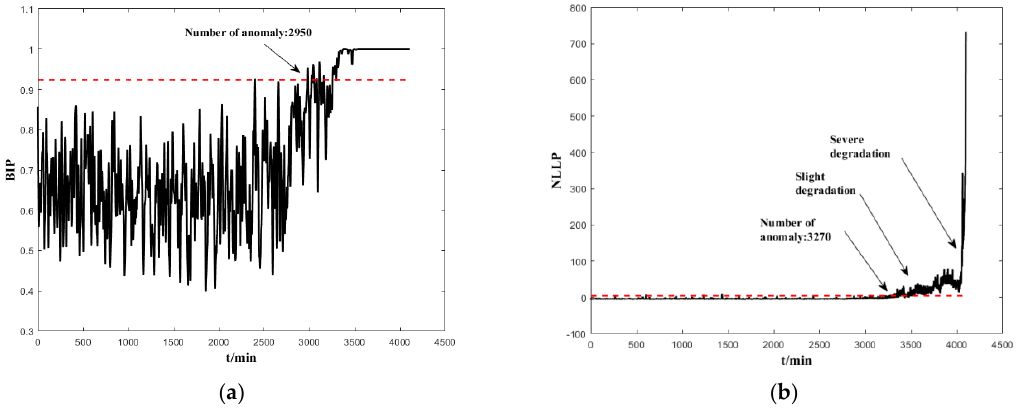
Figure 9. Degradation processes of B1 ( a ) BIP and ( b ) negative log-likelihood probability (NLLP).